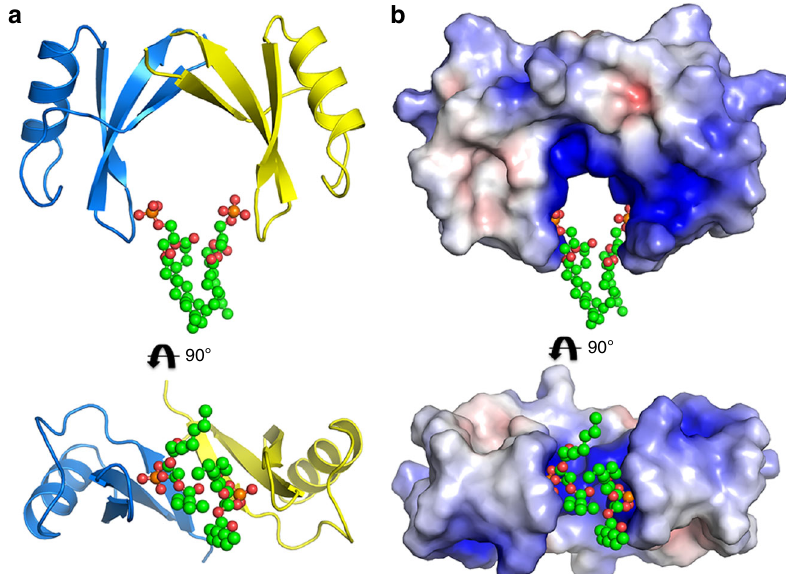
Fig. 2 Crystal structure of the NaD1 – PA dimer. a The NaD1 dimer in its cationic grip con fi guration (blue and yellow cartoon representation) bound to two molecules of PA (ball and stick with carbons in green, oxygen in red and phosphorus in orange). b Electrostatic surface representation of a highlighting the cationic charge in the grip cavity, which engage the head groups of bound